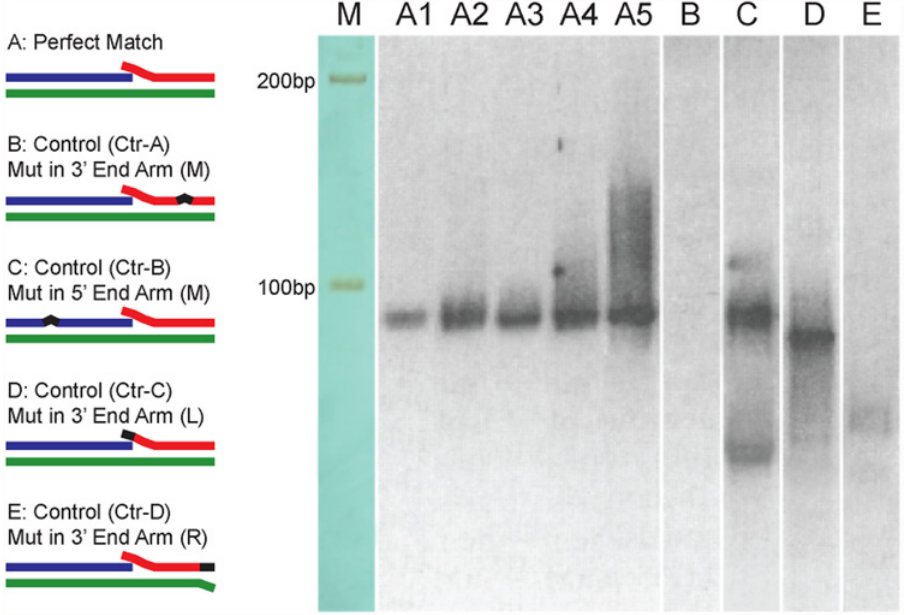
Fig 2. Testing the miRNA quantification system using pincer probes and controls. The lane designated “ M ” represents the size maker with an upper band of 200 bp and a lower band of 100 bp. The perfectly matched pincer probe and its target miRNA were actively reverse transcribed and were ciRNA tagged (lanes A1 to A5). The total amounts of miRNA in lanes A1 to A5 were 0.5, 1, 2, 4, and 8 pmol, respectively. The quantified amounts for bands A1 to A5 were 335.06, 662.25, 676.20, 1,345.30, and 2,547.50, respectively (Gel-Pro Analyzer). The mutations in the control probes were located in the middle of the arms (Ctr-A in the left arm and Ctr-B in the right arm) or in the 3 0 cohesive end of the miRNA/pincer-probe duplex (Ctr-C in the pincer probe and Ctr-D in miRNA). Reverse transcription of miRNA with pincer-probe controls A, C and D (lanes B, D and E) did not produce correct products required for miRNA quantification. The pincer-probe control B (lane C) produced observable signal indicated that the assay may less to be precise if the mutation is close to the 5 0 end. The reverse transcription product was detected using chemiluminescent